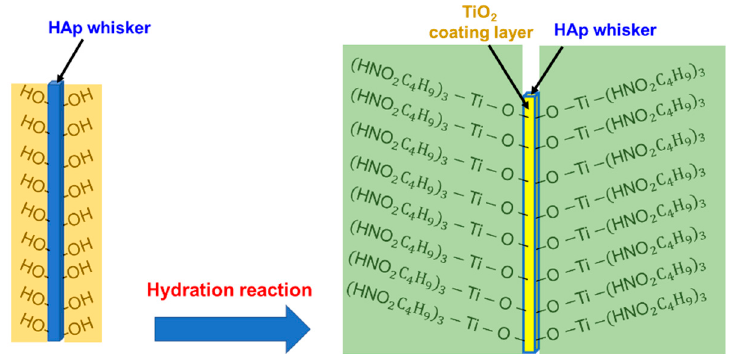
Figure 1. Diagram illustration of the formation of a continuous TiO 2 coating layer around the surface of the HAp whiskers via the hydration reaction between the surface hydroxyl of HAp and hydrolyzed Ti(OC 4 H 9 ) 4 .